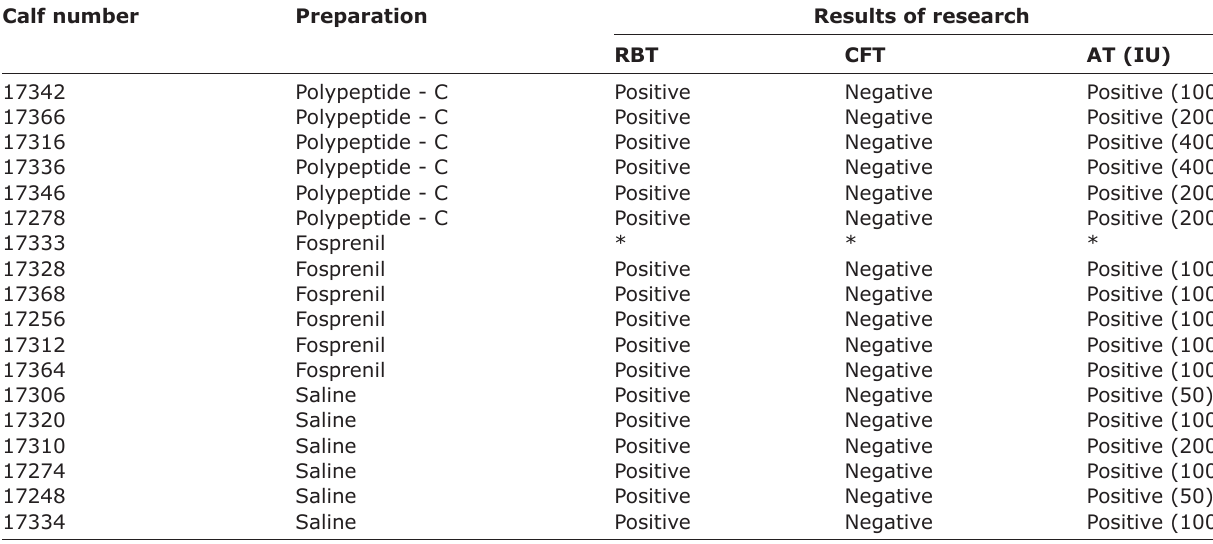
Table-1: The results of serological tests 14 days after vaccination (n=18). Calf